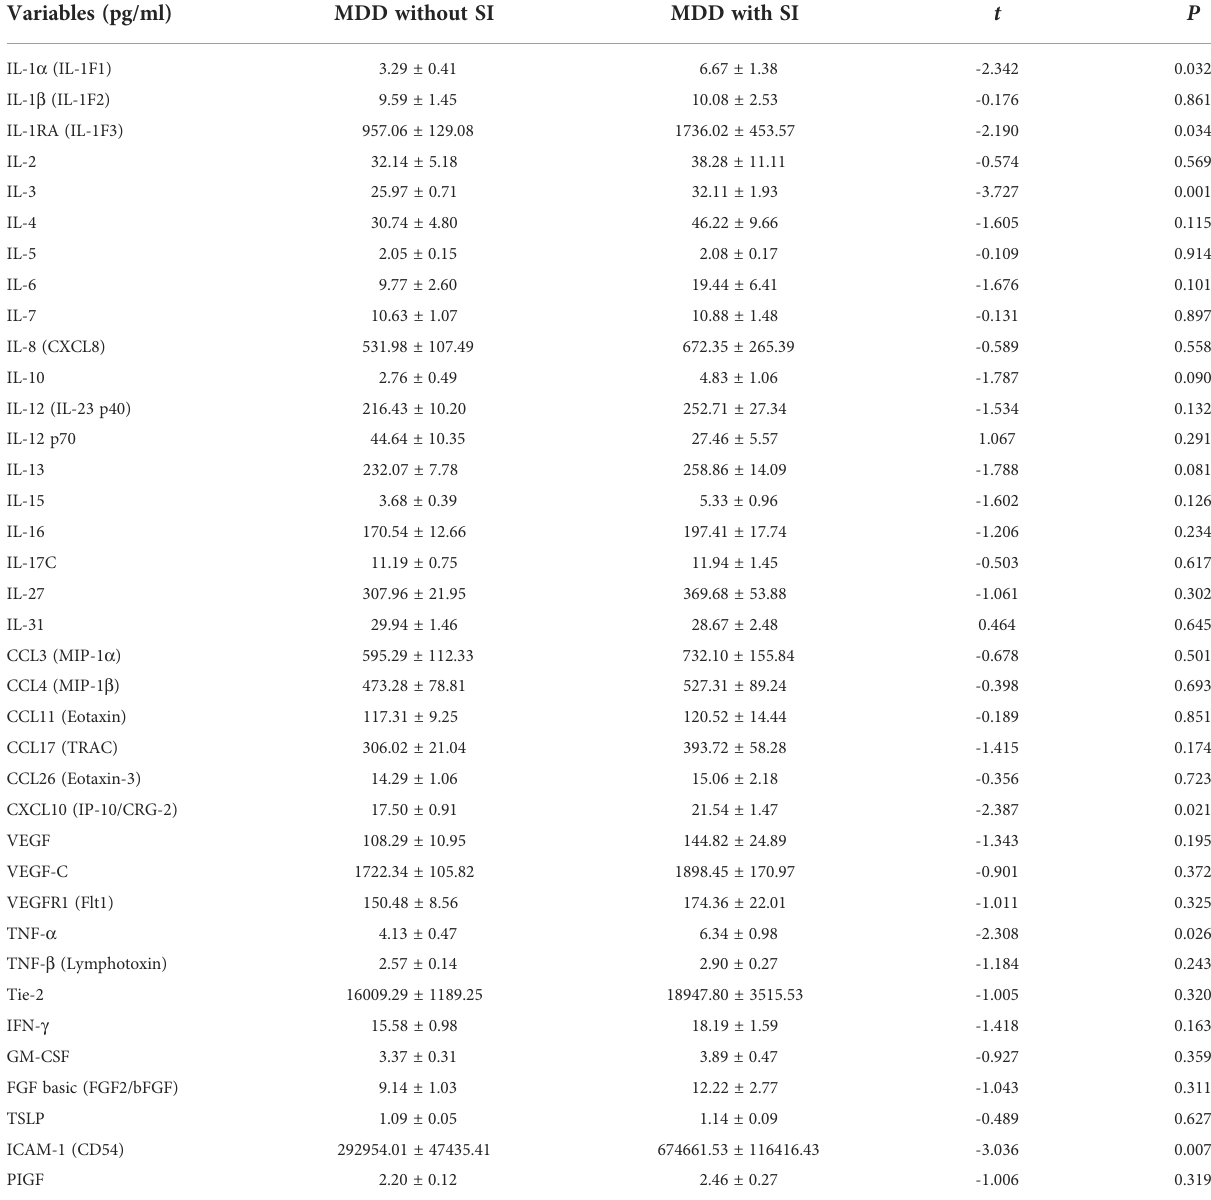
TABLE 3 Comparison of serum cytokines between MDD patients without SI and MDD patients with SI. Variables (pg/ml) MDD without SI MDD with SI t